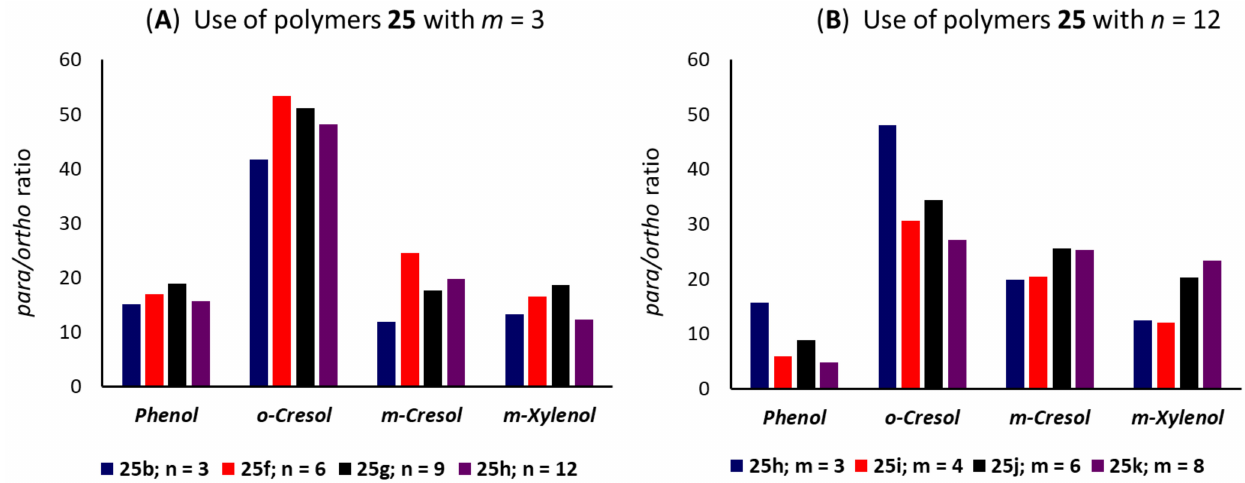
Figure 11. Effect of polymers 25 having m (cid:54) = n on the selectivity of chlorination of phenols according to Scheme 1. Conditions were as described in the footnote to Figure 10. ( A ) Use of polymers 25 with m = 3 and n as indicated at the foot of the chart; ( B ) Use of polymers 25 with n = 12 and m as indicated at the foot of the